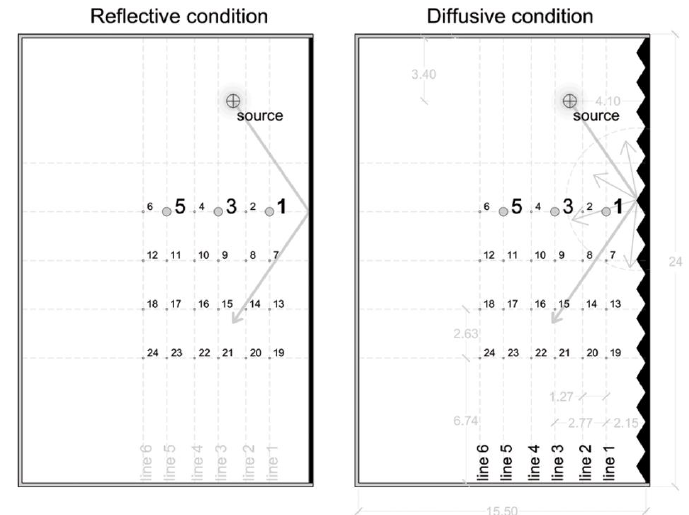
Figure 2. Scheme of the plan for the two acoustic conditions in the hall: reflective and diffusive. The other surfaces in gray were set in an absorptive condition, except for the floor, which was made of a hard reflective surface. The 24 microphone positions are indicated in a crossed array that occupies half of the hall. Positions 1, 3, and 5 were used to perform the binaural simulations and then in the listening test.